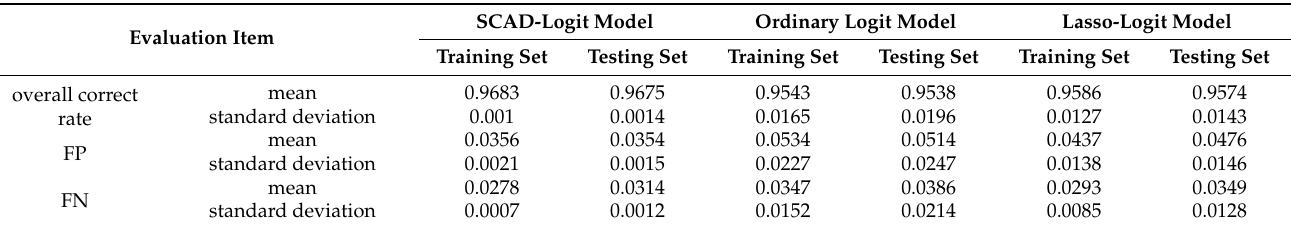
Table 8. Results of performance evaluation.